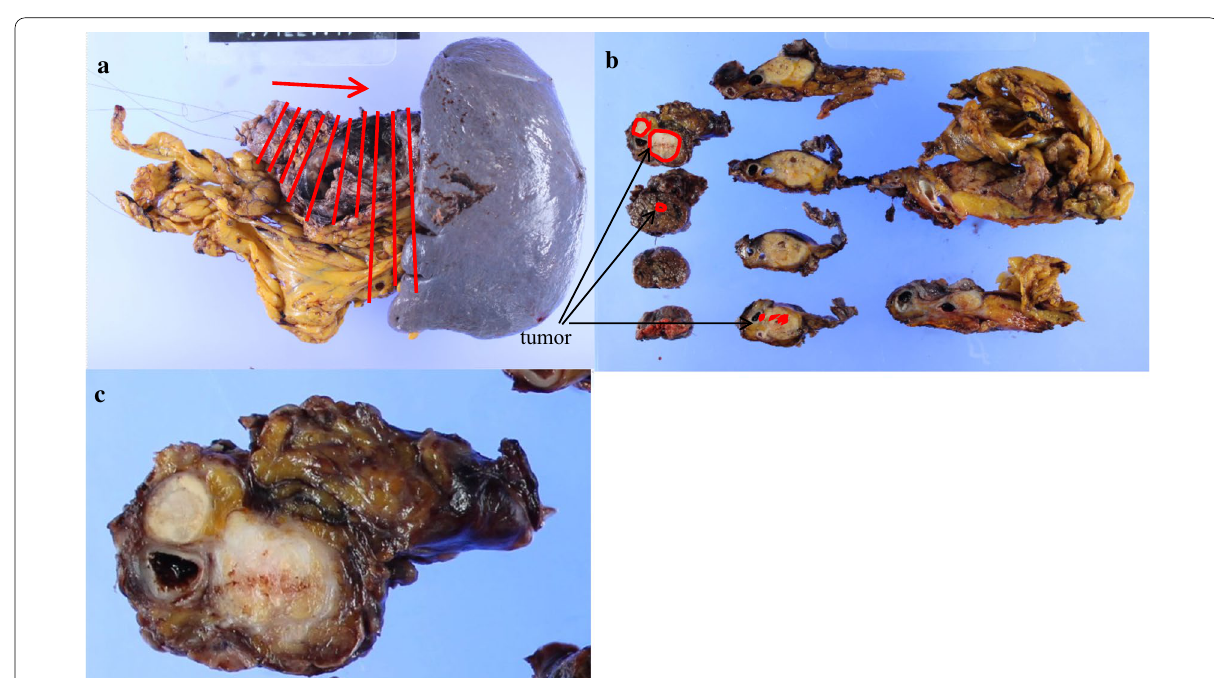
Fig. 4 Resected specimen. a The resected specimen. Cutting lines of the resected specimen are shown (lines). b Gross description. The tumor cells represented in the circled area. c Solid tumors are seen in the macroscopic